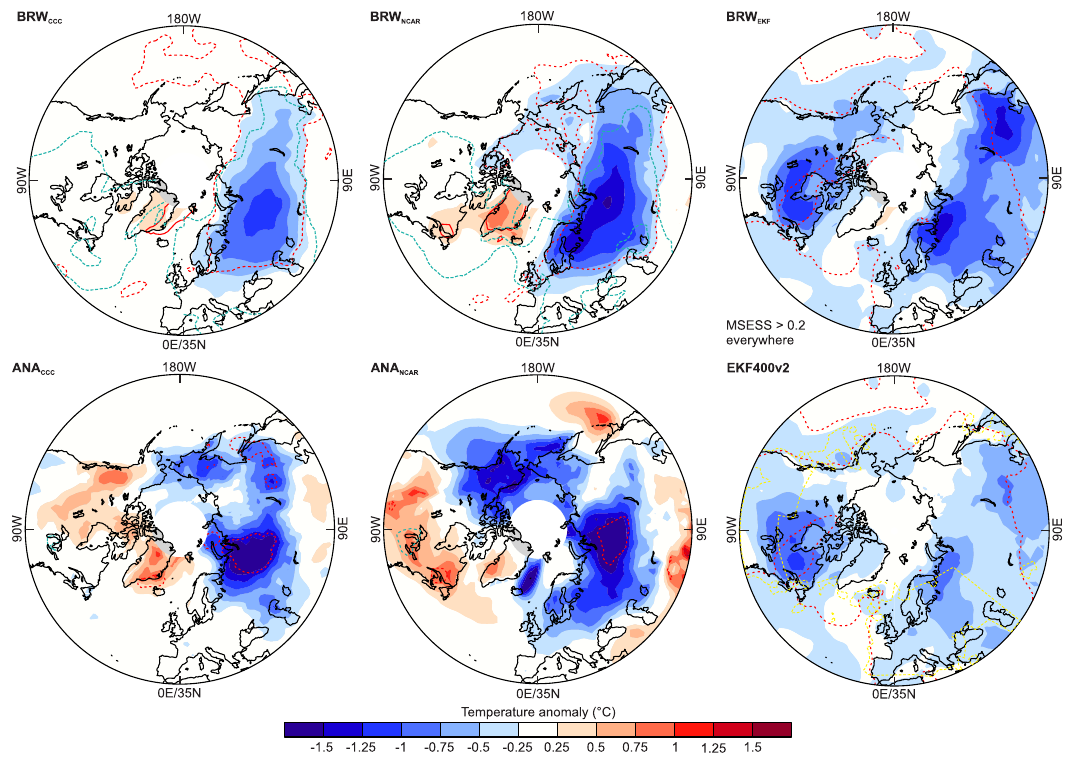
Fig. 2 Cold-season temperature anomalies (with respect to 1851 – 1900) during the cold spell in the early 19th century in different reconstructions. Anomalies in 1808/9 – 1815/6 in BRW CCC , BRW NCAR , ANA CCC , ANA NCAR , BRW EKF , and EKF400v2. Dashed ( − 1) and solid ( + 1) red lines express anomalies in standard deviations of the 1851 – 1900 period. The green dashed lines indicate a MSESS of 0.2 relative to EKF400v2 (the yellow dashed line in EKF400 indicates an MSESS of 0.2 relative to HadCRUT5 56 , which is not spatially